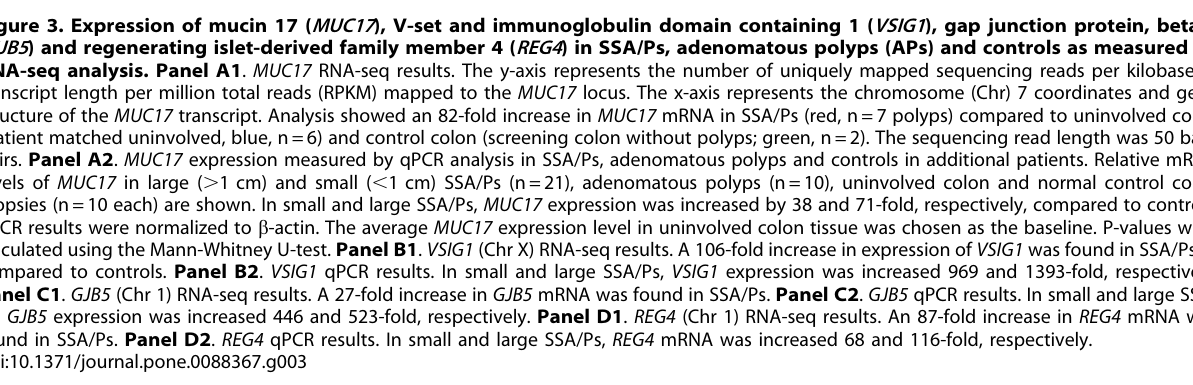
Figure 3. Expression of mucin 17 ( MUC17 ), V-set and immunoglobulin domain containing 1 ( VSIG1 ), gap junction protein, beta 5 ( GJB5 ) and regenerating islet-derived family member 4 ( REG4 ) in SSA/Ps, adenomatous polyps (APs) and controls as measured by RNA-seq analysis. Panel A1 . MUC17 RNA-seq results. The y-axis represents the number of uniquely mapped sequencing reads per kilobase of transcript length per million total reads (RPKM) mapped to the MUC17 locus. The x-axis represents the chromosome (Chr) 7 coordinates and gene structure of the MUC17 transcript. Analysis showed an 82-fold increase in MUC17 mRNA in SSA/Ps (red, n=7 polyps) compared to uninvolved colon (patient matched uninvolved, blue, n=6) and control colon (screening colon without polyps; green, n=2). The sequencing read length was 50 base pairs. Panel A2 . MUC17 expression measured by qPCR analysis in SSA/Ps, adenomatous polyps and controls in additional patients. Relative mRNA levels of MUC17 in large ( . 1 cm) and small ( , 1 cm) SSA/Ps (n=21), adenomatous polyps (n=10), uninvolved colon and normal control colon biopsies (n=10 each) are shown. In small and large SSA/Ps, MUC17 expression was increased by 38 and 71-fold, respectively, compared to controls. qPCR results were normalized to b -actin. The average MUC17 expression level in uninvolved colon tissue was chosen as the baseline. P-values were calculated using the Mann-Whitney U-test. Panel B1 . VSIG1 (Chr X) RNA-seq results. A 106-fold increase in expression of VSIG1 was found in SSA/Ps as compared to controls. Panel B2 . VSIG1 qPCR results. In small and large SSA/Ps, VSIG1 expression was increased 969 and 1393-fold, respectively. Panel C1 . GJB5 (Chr 1) RNA-seq results. A 27-fold increase in GJB5 mRNA was found in SSA/Ps. Panel C2 . GJB5 qPCR results. In small and large SSA/ Ps, GJB5 expression was increased 446 and 523-fold, respectively. Panel D1 . REG4 (Chr 1) RNA-seq results. An 87-fold increase in REG4 mRNA was